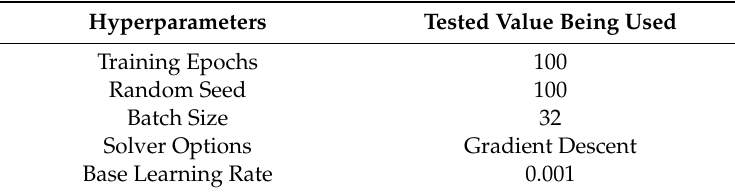
Table 5. Optimized